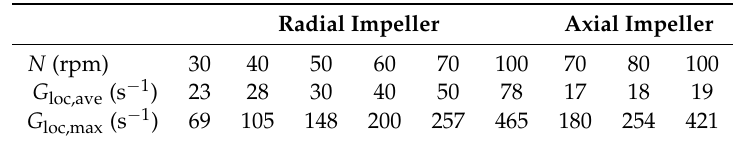
Figure 8. The cumulative distribution of the local velocity gradients in the jar, equipped with the radial and the axial mixers, for different impeller speeds. Table 1. The average and maximum local velocity gradient ( G loc,ave and G loc,max ), derived from the CFD simulations, for all jar test setups tested in this